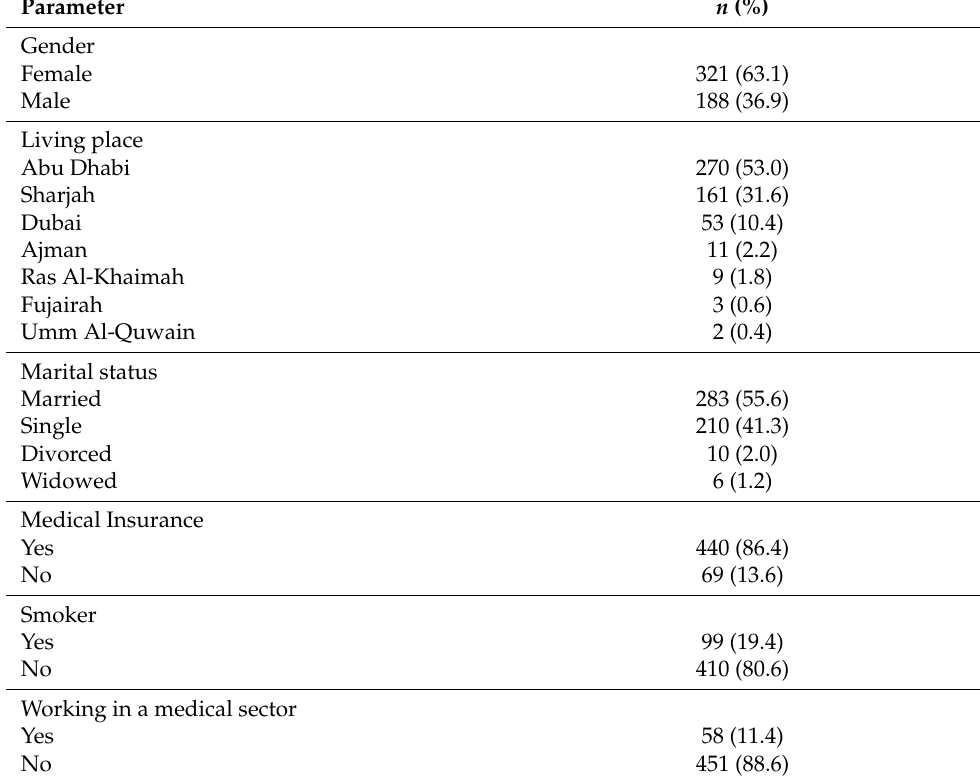
Table 1. Demographic characteristics of the study participants ( n =